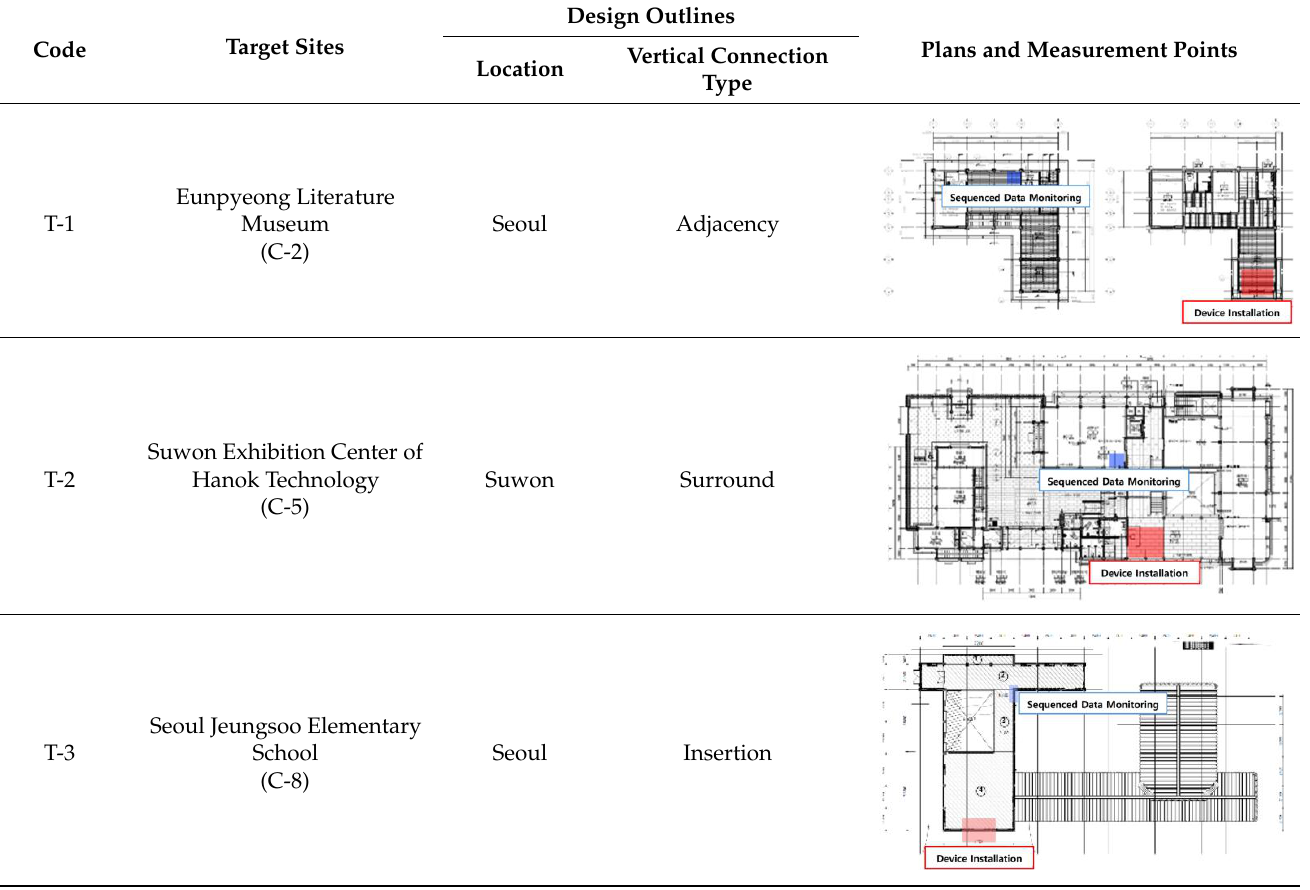
Figure 3. Operation schedules of selected target Hanoks.